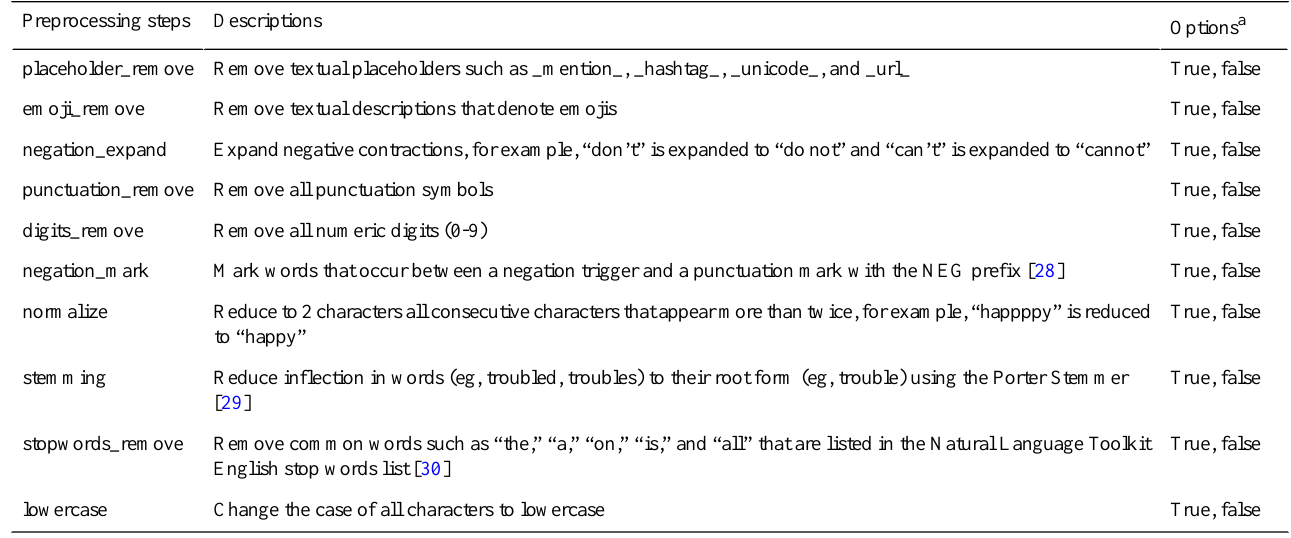
Table 2. Description of preprocessing steps and options used in traditional